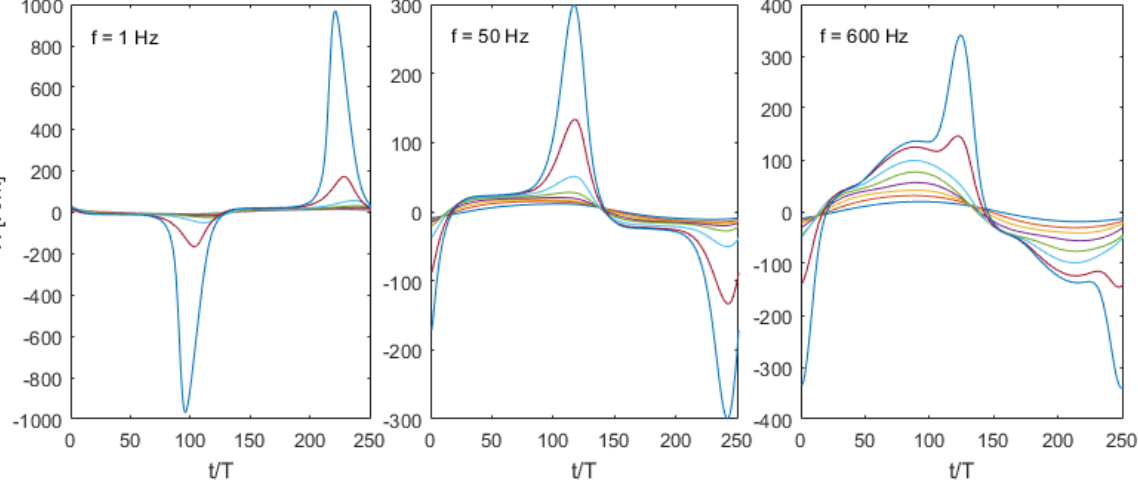
Figure 2. Families of eight magnetic-field waveforms, measured at f = 1 Hz ( left panel), f = 50 Hz ( center panel), and f = 600 Hz ( right panel), obtained after the feedback convergence to acquire purely sinusoidal magnetic inductions between 0.2 T and 1.5 T.